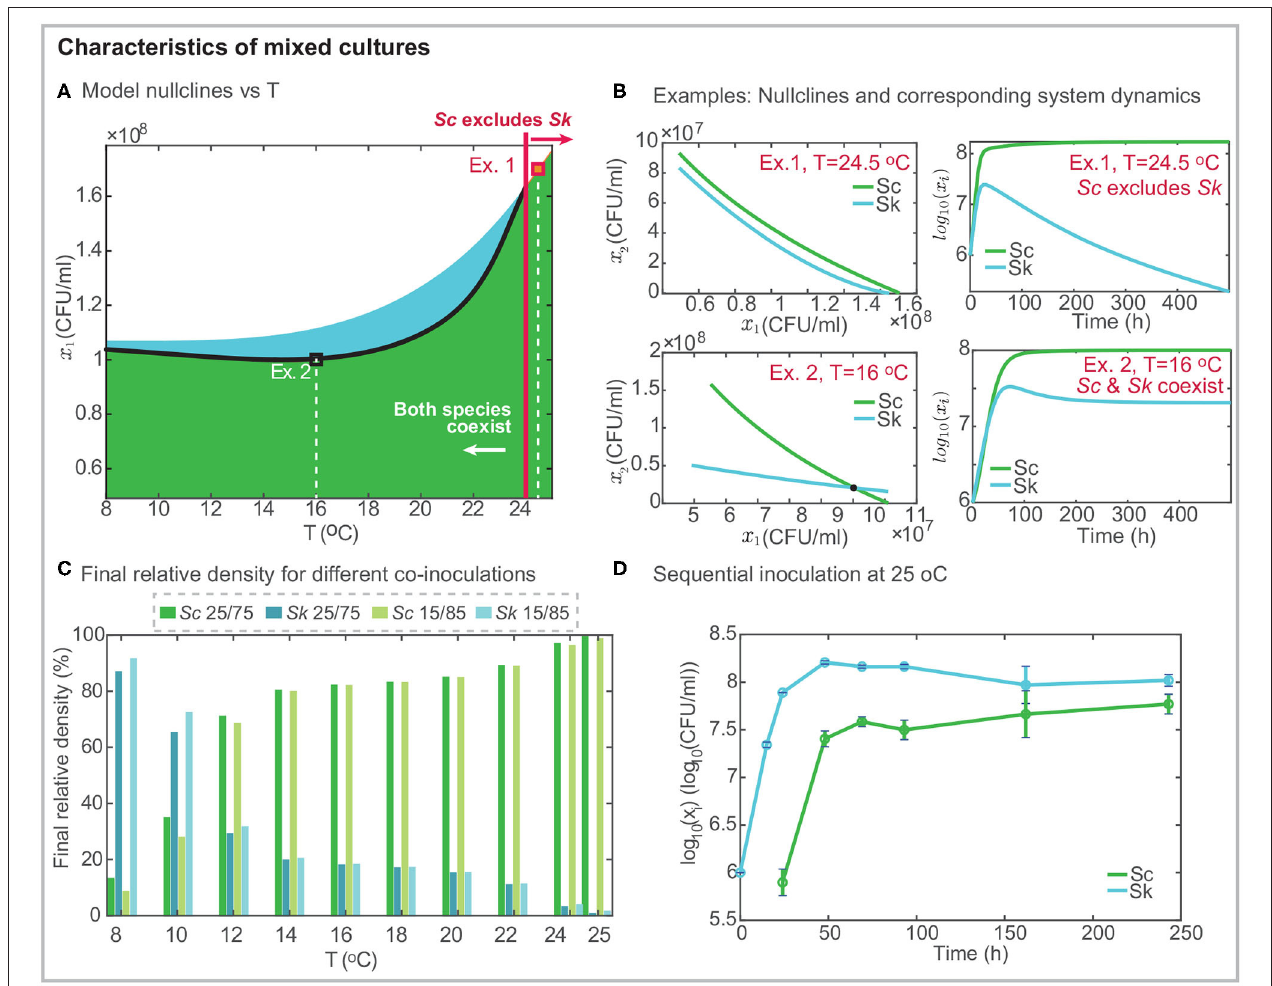
FIGURE 3 | Characteristics of mixed cultures. (A) presents the projection of the model nullclines over the temperature and the final density of Sk ; the black line shows the intersection between the nullclines indicating the range of temperatures for which both cells coexist independently of the initial inoculation. Black and red squares mark two different examples: Ex. 1 at T = 24.5 ◦ C in which Sc excludes Sk and Ex.2 at T = 16 ◦ C in which both strains coexist. (B) shows the model nullclines for the two examples and the corresponding mixed culture dynamics. (C) presents the density in % for both cells in mixed culture after around 10 days , as a function of temperature and considering two different co-inoculation conditions. The percentage of Sk exceeds that of Sc at cold temperatures. While the opposite behavior is found for T > 12 ◦ C. For T > 24 ◦ C Sk is excluded. (D) presents an illustrative example of sequential inoculation at 25 ◦ C showing how both species may